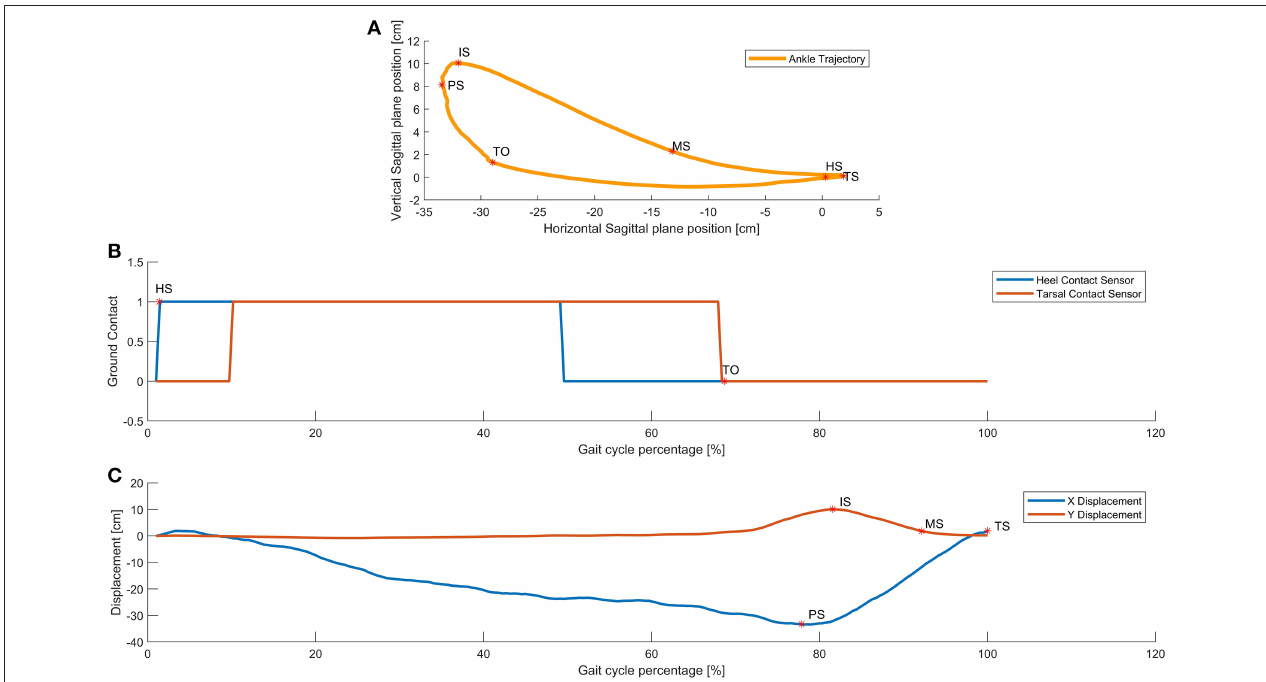
FIGURE 3 | Walking events detection. In subfigure (A) Gait cycle key events calculated via forward kinematics of captured data. Subfigures (B) and (C) , show the ground contact and displacements of the ankle as functions of the percentace of the gait cycle. walking forward means moving left to right as gait evolves over time. The key events are determined as maximums and minimums identified by direction changes in velocity of the ankle.